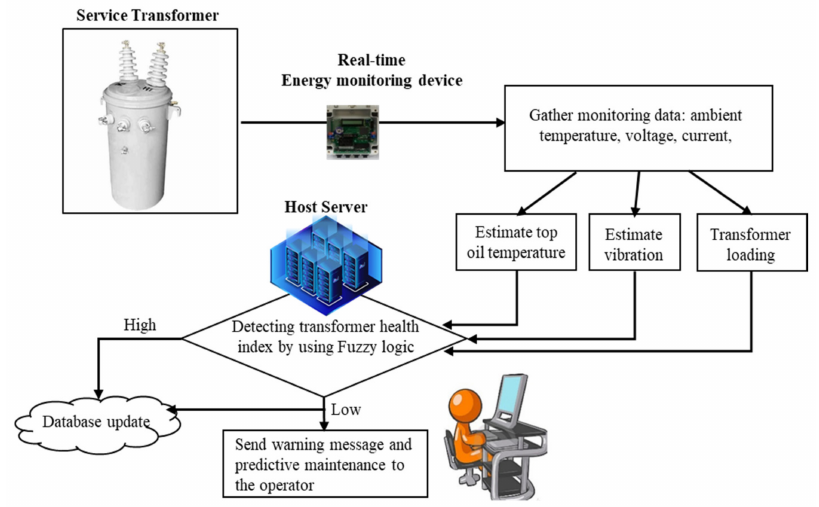
Figure 4. Scheme diagram of the online monitoring system.